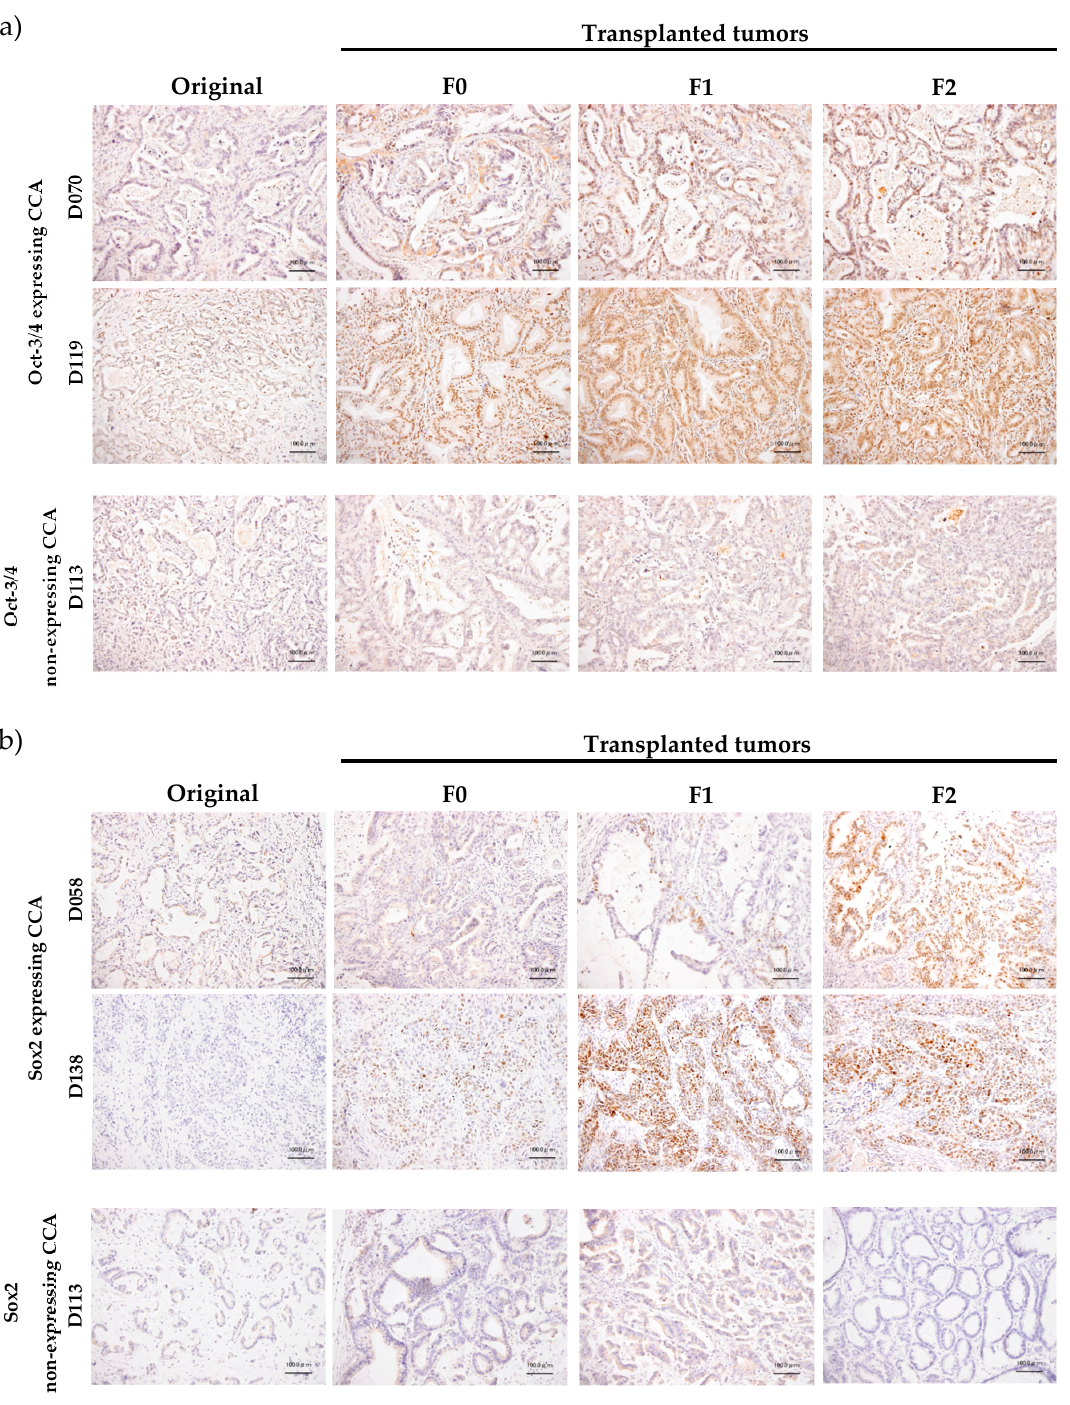
Figure 3. Comparison of Oct-3 / 4 and Sox2 expressions between original tumor tissue from the patient (original) and serially transplanted tissues (F0, F1, and F2). ( a ) Oct-3 / 4; ( b ) Sox2 expressions. Representative samples of nuclear expressing and non-expressing CCA are shown. Bar = 100 μ m.